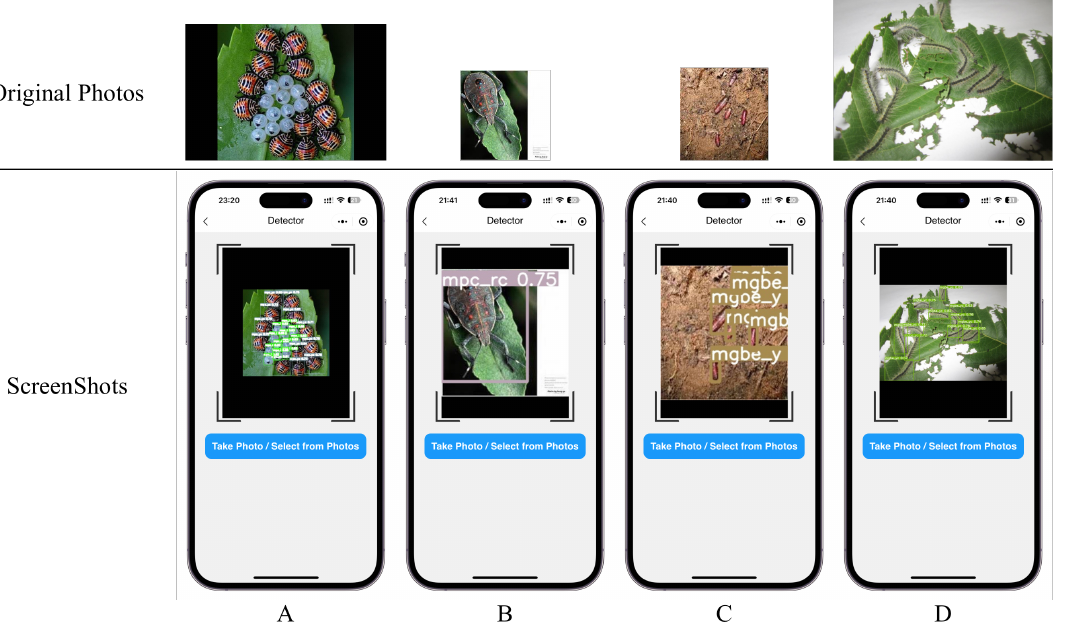
Figure 12. Screenshot of the application detection, top is the original image in different resolutions, bottom is the screenshot of the detection result. ( A – D ) shows the detection results for different densities and resolutions of the original